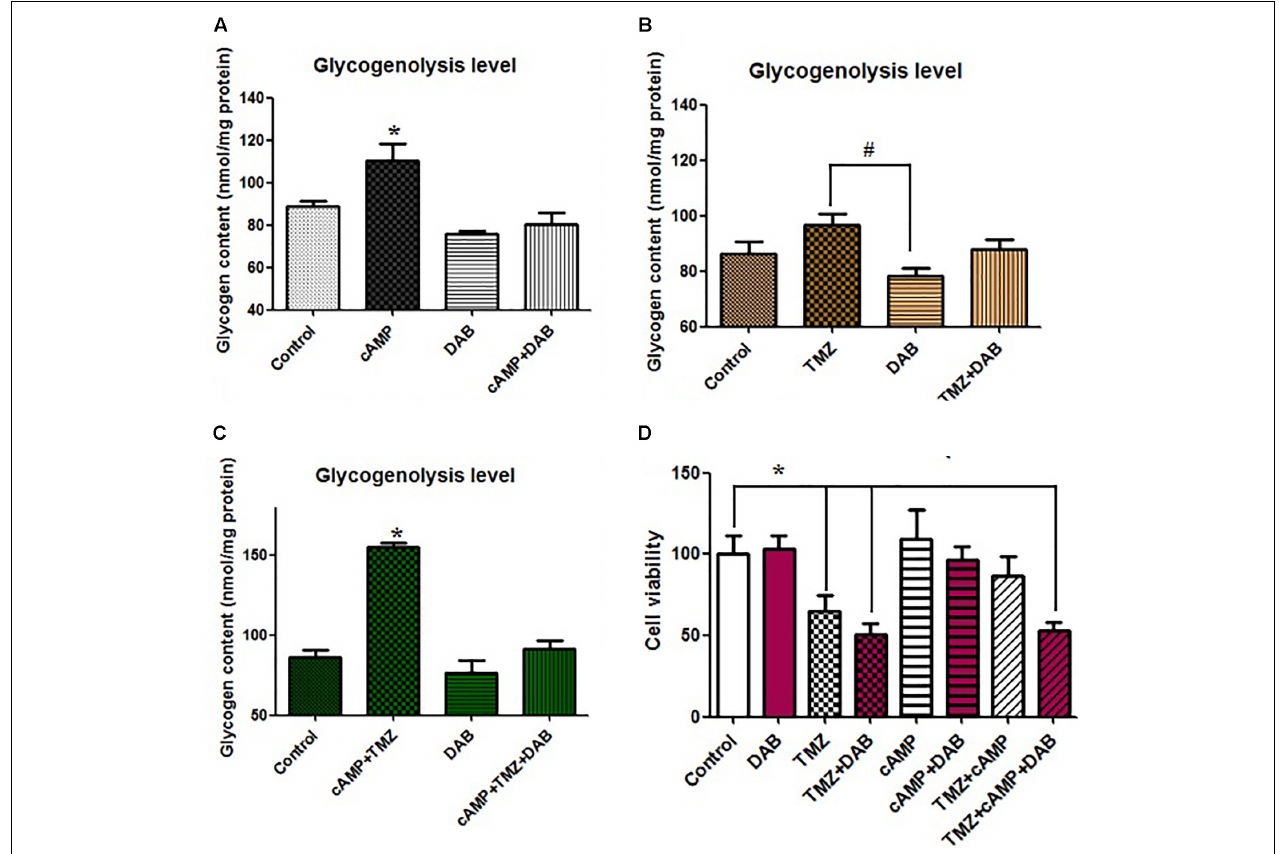
FIGURE 2 | Effect of cAMP and TMZ on glycogenolysis indicated by a reduction in the glycogen content of U251 cells. (A) Cultures were incubated in DMEM (containing 7.5 mM glucose) for 20 min without any addition (Cont) or in the presence of 3 µ M cAMP, with or without 10 mM DAB, an inhibitor of glycogenolysis. (B) Cultures were incubated in DMEM for 20 min under control conditions (Cont) or in the presence of 5 µ M TMZ, with or without 10 mM DAB, an inhibitor of glycogenolysis. (C) Cultures were incubated in DMEM for 20 min under control conditions (Cont) or in the presence of 3 µ M cAMP and 5 µ M TMZ, with or without 10 mM DAB, an inhibitor of glycogenolysis. After the experiment, glycogenolysis was determined by measuring glucose content fluorometrically before and after the breakdown of glycogen remaining in the cells. Mean glycogen contents are indicated as calculated glycogen. Reduced glycogen content indicates high activation levels of glycogenolysis. All values are expressed as means ± SEM, indicated by vertical bars, and are from three to five individual cultures. (D) Cells were incubated for 20 min, and MTT analysis was performed in the absence of any drug (Control) or in the presence of 5 µ M TMZ and/or 3 µ M cAMP, with or without 10 mM DAB, an inhibitor of glycogenolysis. ∗ Indicates a statistically significant ( P < 0.05) difference from negative controls while # indicates a statistically significant ( P < 0.05) difference from